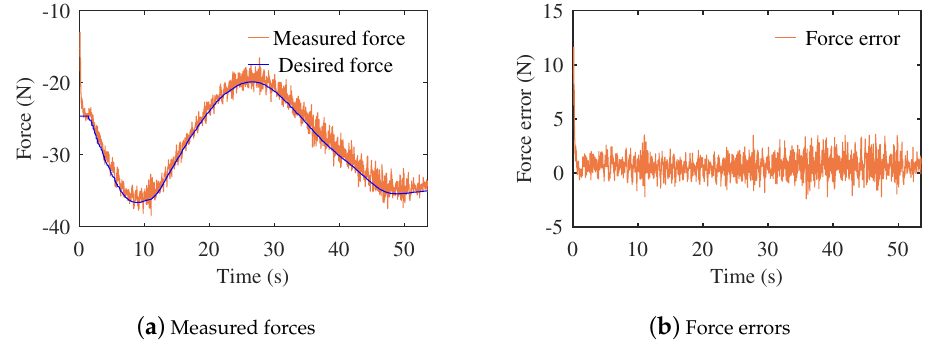
Figure 11. Measured force and force errors under motion modeled by DMP and no interactions. The measured trajectory of the experiment is shown in Figure 12a under the robot moving from the free space. As the robot moves from the free space, the measured trajectory gradually becomes close to the demonstration trajectory. When the robot reaches the contact space, the value of α is 0.18 in the motion controller of the second subtask. The pose errors of the whole process of the robot motion are shown in Figure 12b. The contact force and force errors of the experiment are shown in Figure 13. The robot reaches contact space and is controlled by the motion controller of the first subtask after 7 s, which modulates the robot motion to obtain the desired force. When the robot reaches the contact space, both the position and orientation errors can continue reducing, as shown in Figure 12b. When the robot tracks the desired force, the biggest absolute value of the force error is 4.44 N. The proposed method can ensure the robot begins working from free